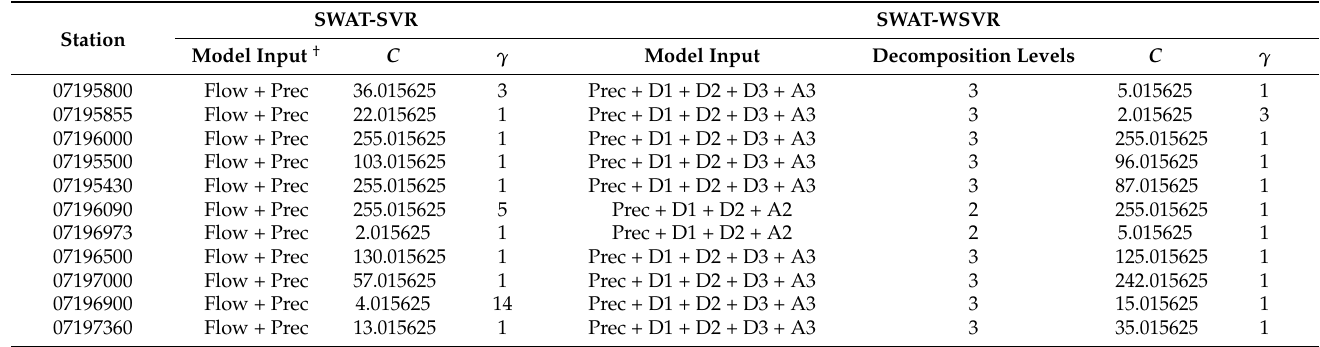
Table 5. Model inputs and optimum parameters of SWAT-SVR and